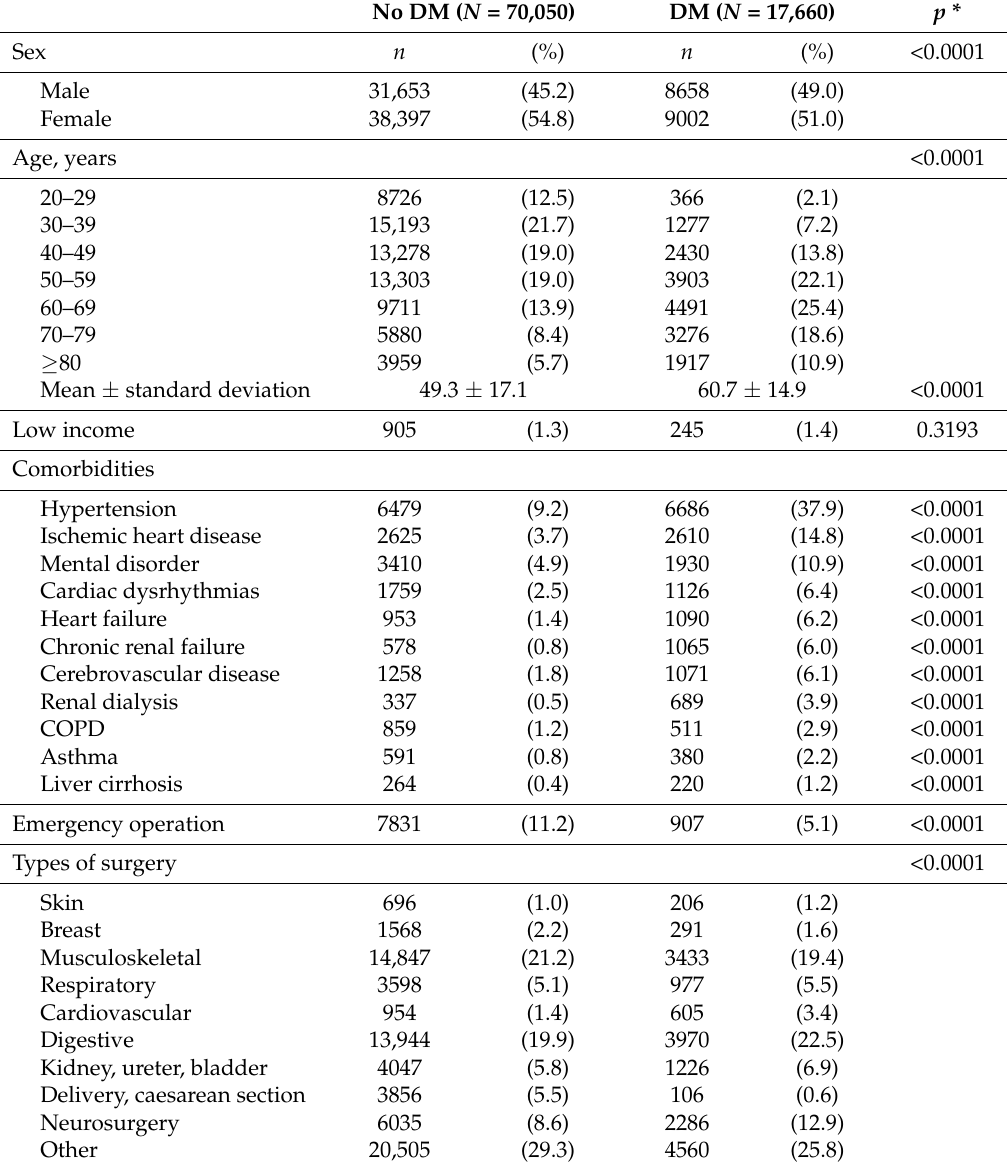
Table 1. Baseline characteristics of surgical patients with and without diabetes before